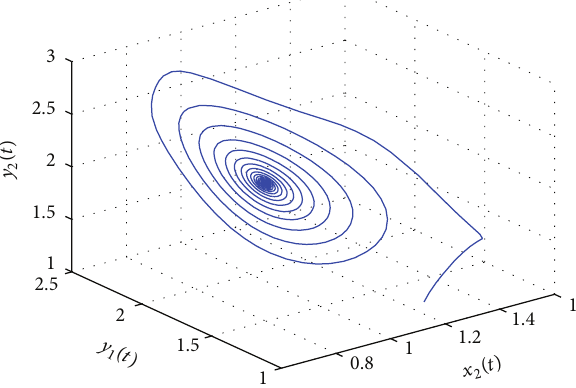
Figure 14: The phase plot of the states 𝑥 1 , 𝑥 2 , 𝑦 2 for 𝜏 = 2.7500 < = 3.1043 . 𝜏 0